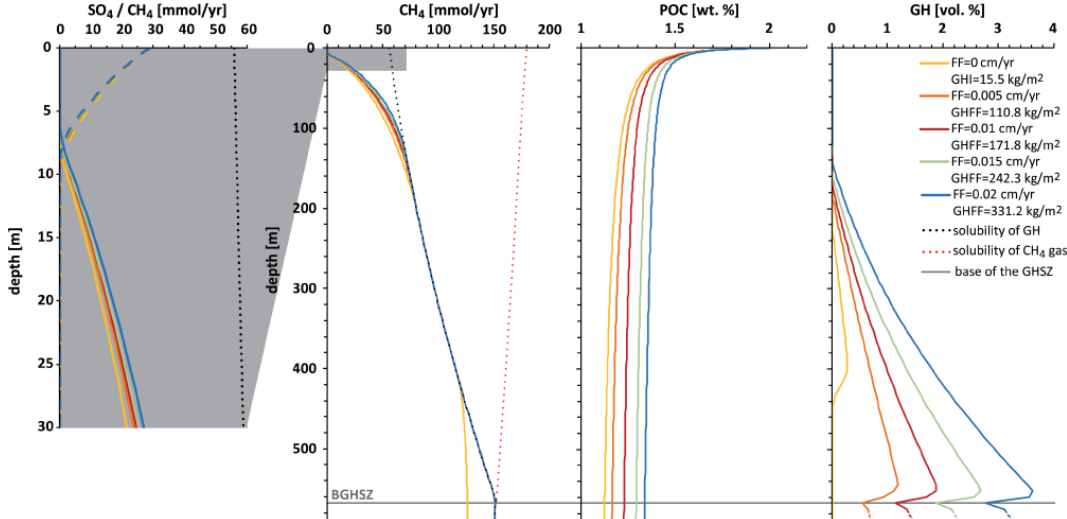
Fig. 6. Model results considering five different fluid advection rates (0, 0.05, 0.01, 0.015, and 0.02cmyr − 1 ), for POC of 2wt.%, a SR of 20cmkyr − 1 and L GHSZ of 567m, including concentration of dissolved sulfate (SO 4 , dashed line), dissolved methane (CH 4 ), particulate organic carbon (POC), and concentrations of gas hydrates (GH) in the gas hydrate stability zone (GHSZ), and free methane gas below it (dashed lines). The solubility of methane hydrate (black dashed line in the CH 4 and SO 4 plots) was calculated using Tishchenko et al. (2005). Depth integrated masses of gas hydrates per area seafloor are provided (GHI or GH FF in kgm − 2